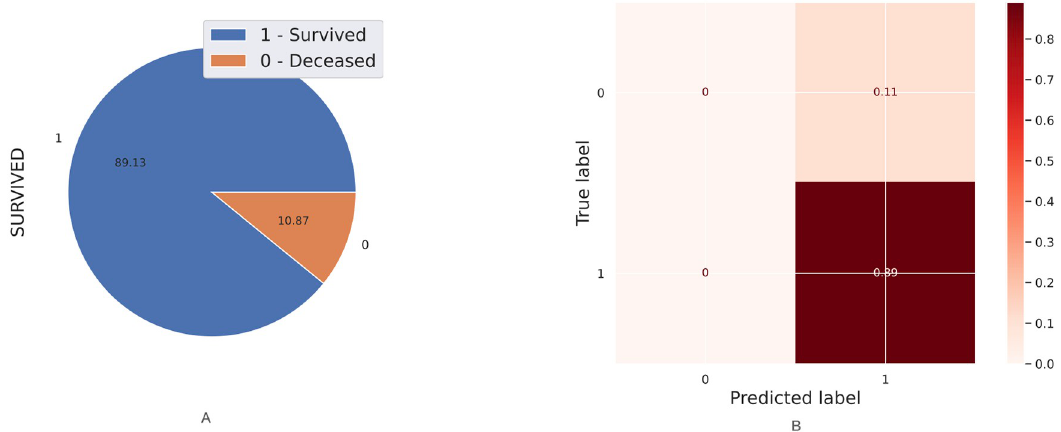
Fig 8. Analysis of survived versus deceased patients. (A): Percent relation between survived and deceased patients. (B): Confusion matrix using classical Machine Learning Methods.